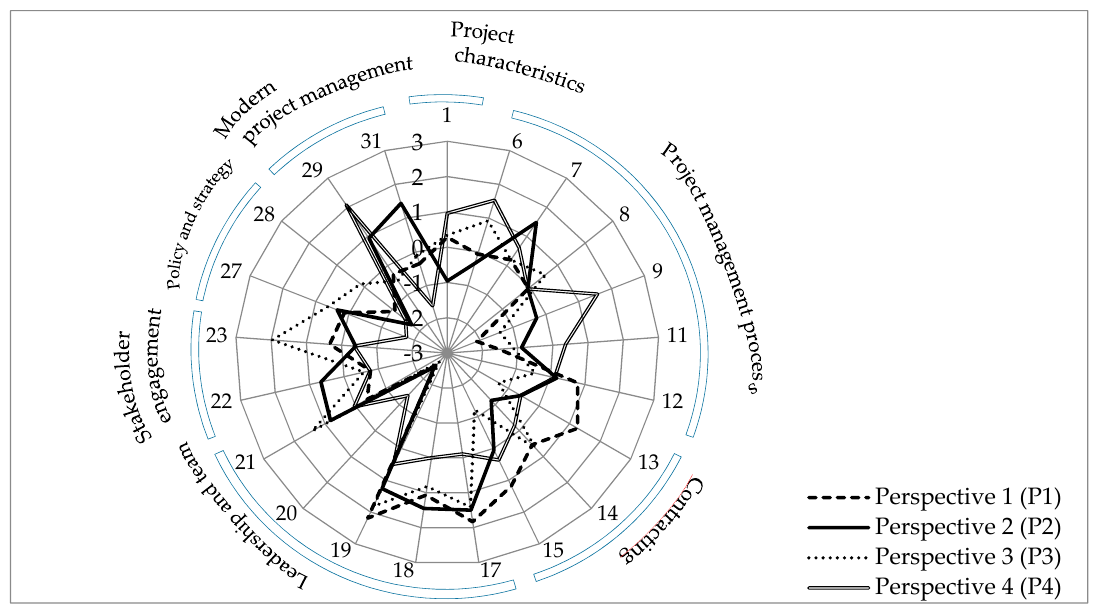
Figure 6. Comparing distinguishing success factors and categories across perspectives.